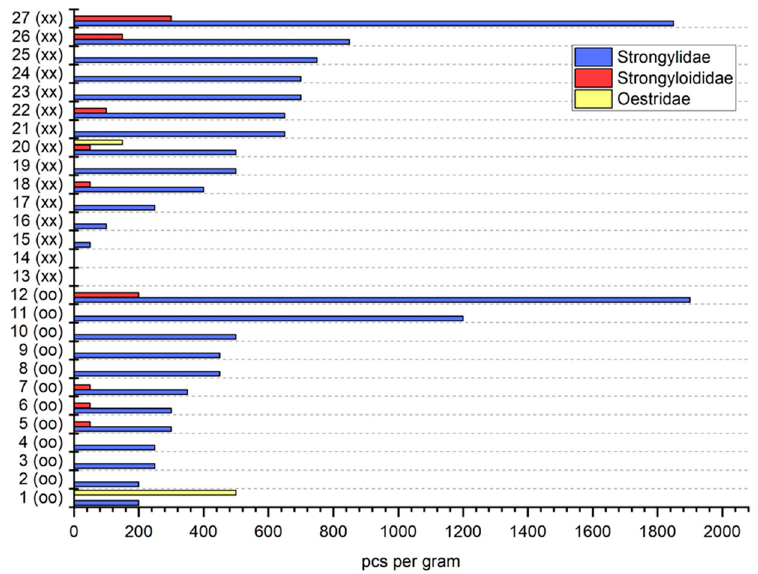
Figure 4. Numbers of eggs/larvae of parasites in stool samples of Arabian horses and Thorough-